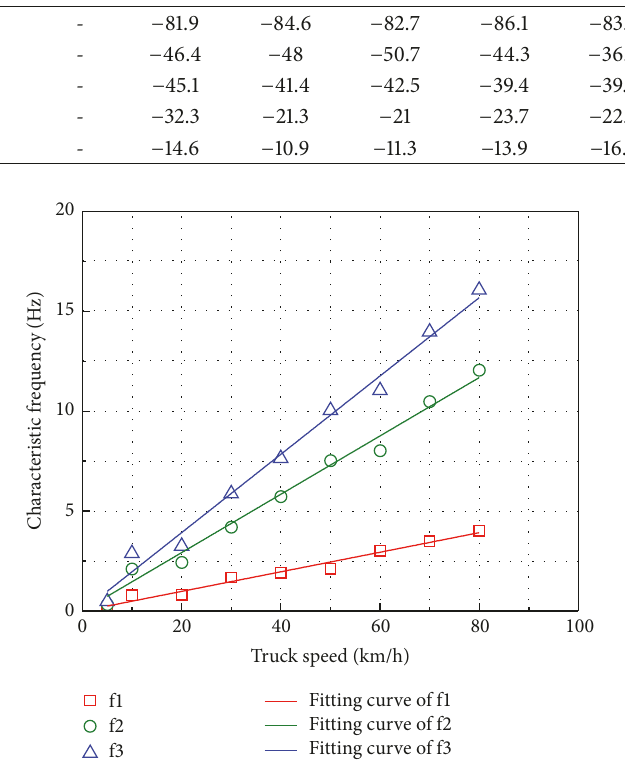
Figure 12: Relationship between truck speed and dominant frequency on the top of the base